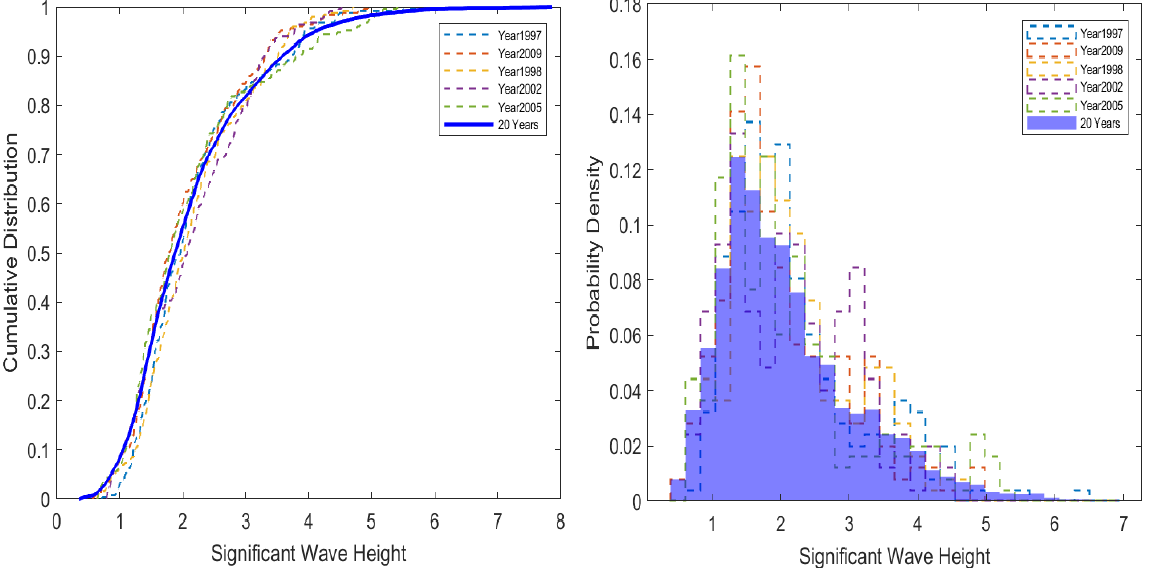
Figure 2. The cumulative distributions ( left ) and probability densities ( right ) of the significant wave height in March from five candidate months yielded by the component of JS divergence.